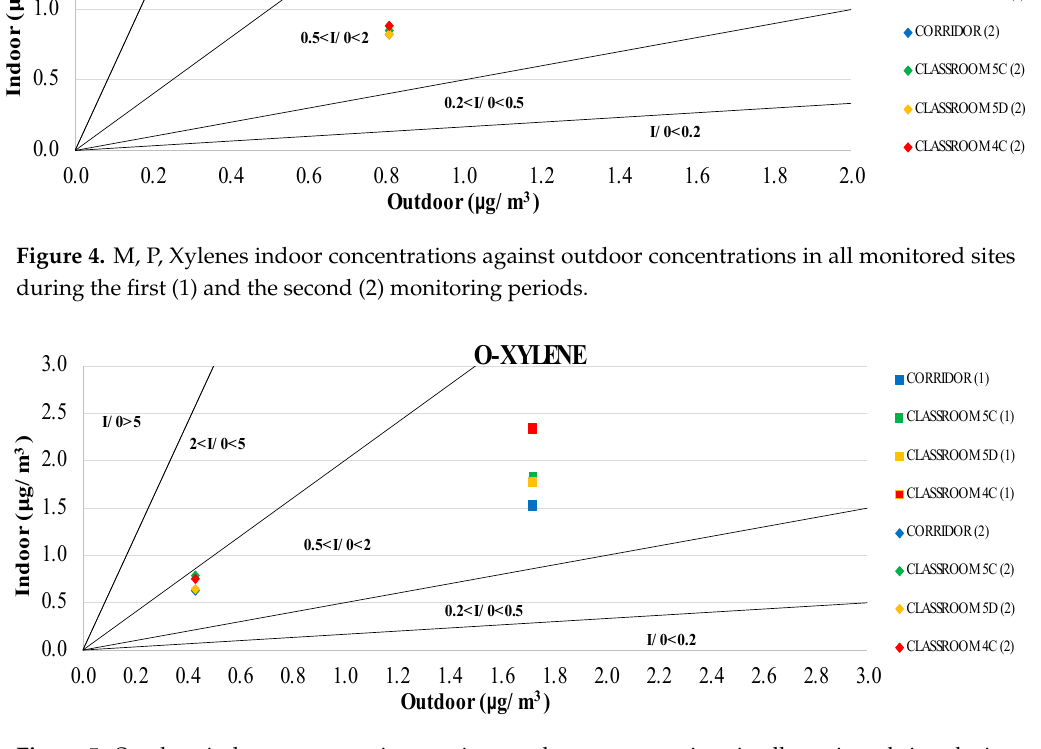
Figure 5. O -xylene indoor concentrations against outdoor concentrations in all monitored sites during Figure 5. O- xylene indoor concentrations against outdoor concentrations in all monitored sites during Figure 5. O- xylene indoor concentrations against outdoor concentrations in all monitored sites during the first (1) and the second (2) monitoring the first (1) and the second (2) monitoring periods. Figure 5. O- xylene indoor concentrations against outdoor concentrations in all monitored sites during the first (1) and the second (2) monitoring periods. the first (1) and the second (2) monitoring periods.